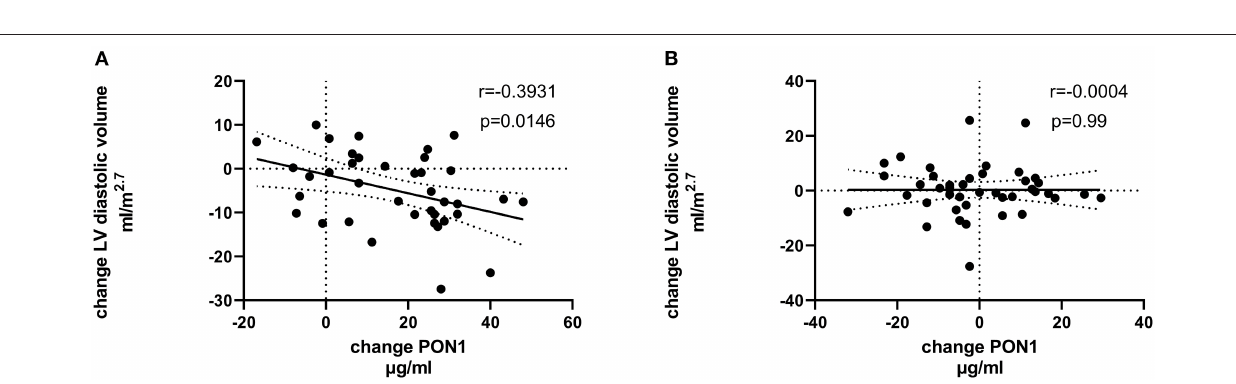
FIGURE 5 | Change in LV systolic volume vs. change in PON1 mass. (A) Transplant group. (B) Dialysis group.